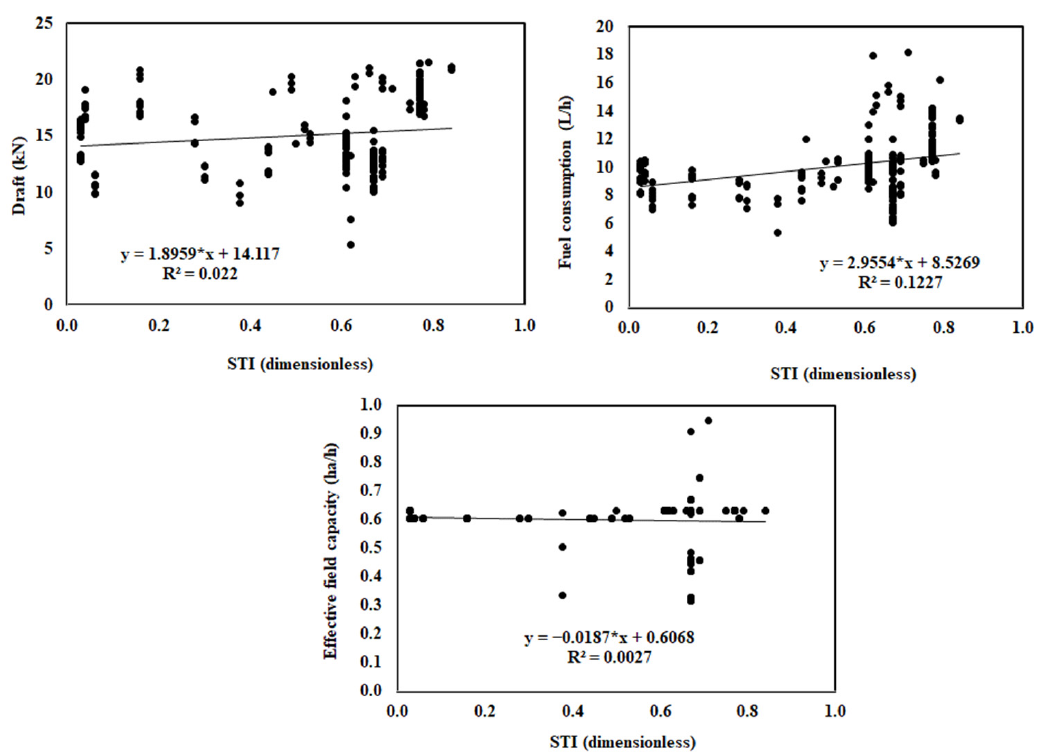
Figure 3. The correlation between the soil texture index (STI) and the performance attributes of effective field capacity, fuel consumption, and draft, during soil tillage operation.